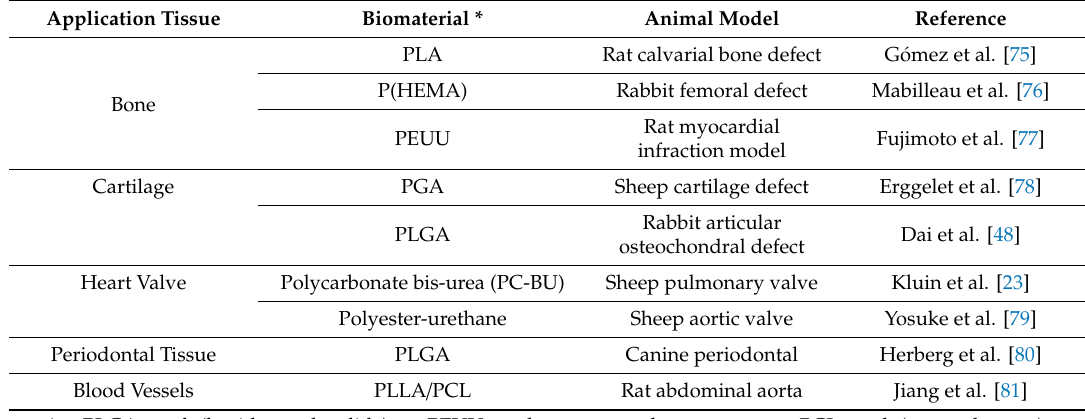
Table 1. Some examples of various synthetic polymer-biomaterials used for in situ tissue